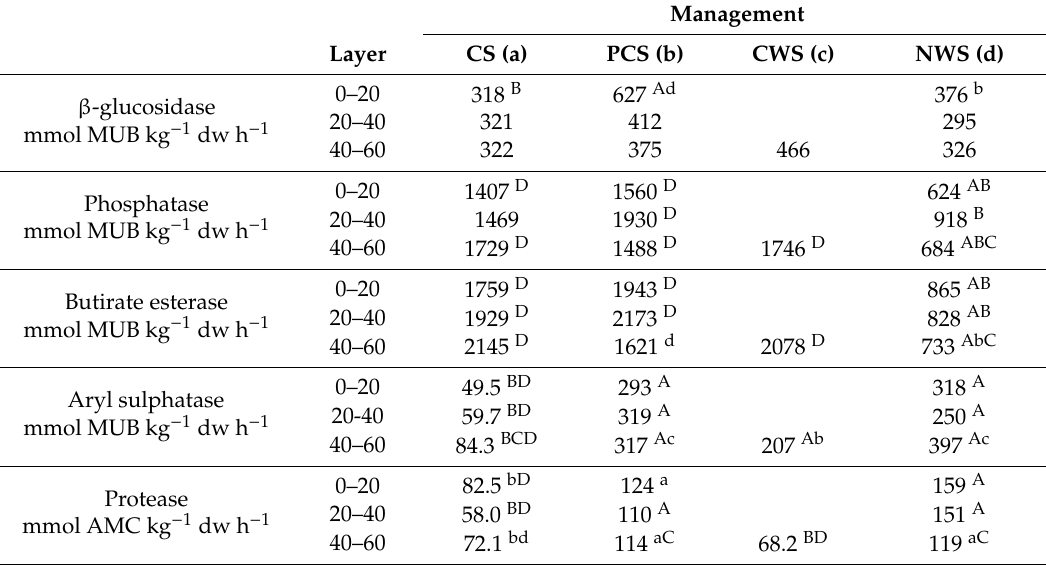
Table 3. ANOVA of soil enzyme activities expressed in mmol MUB kg − 1 dw h − 1 . Statistically significant di ff erences between the respective sites and depths are indicated by superscript indices that denote the significantly di ff erent site: a = CS; b = PCS; c = CWS; d = NWS. Statistically significant di ff erences, with p < 0.01, are indicated by uppercase letters, and those with 0.01 < p < 0.05 are indicated by lowercase